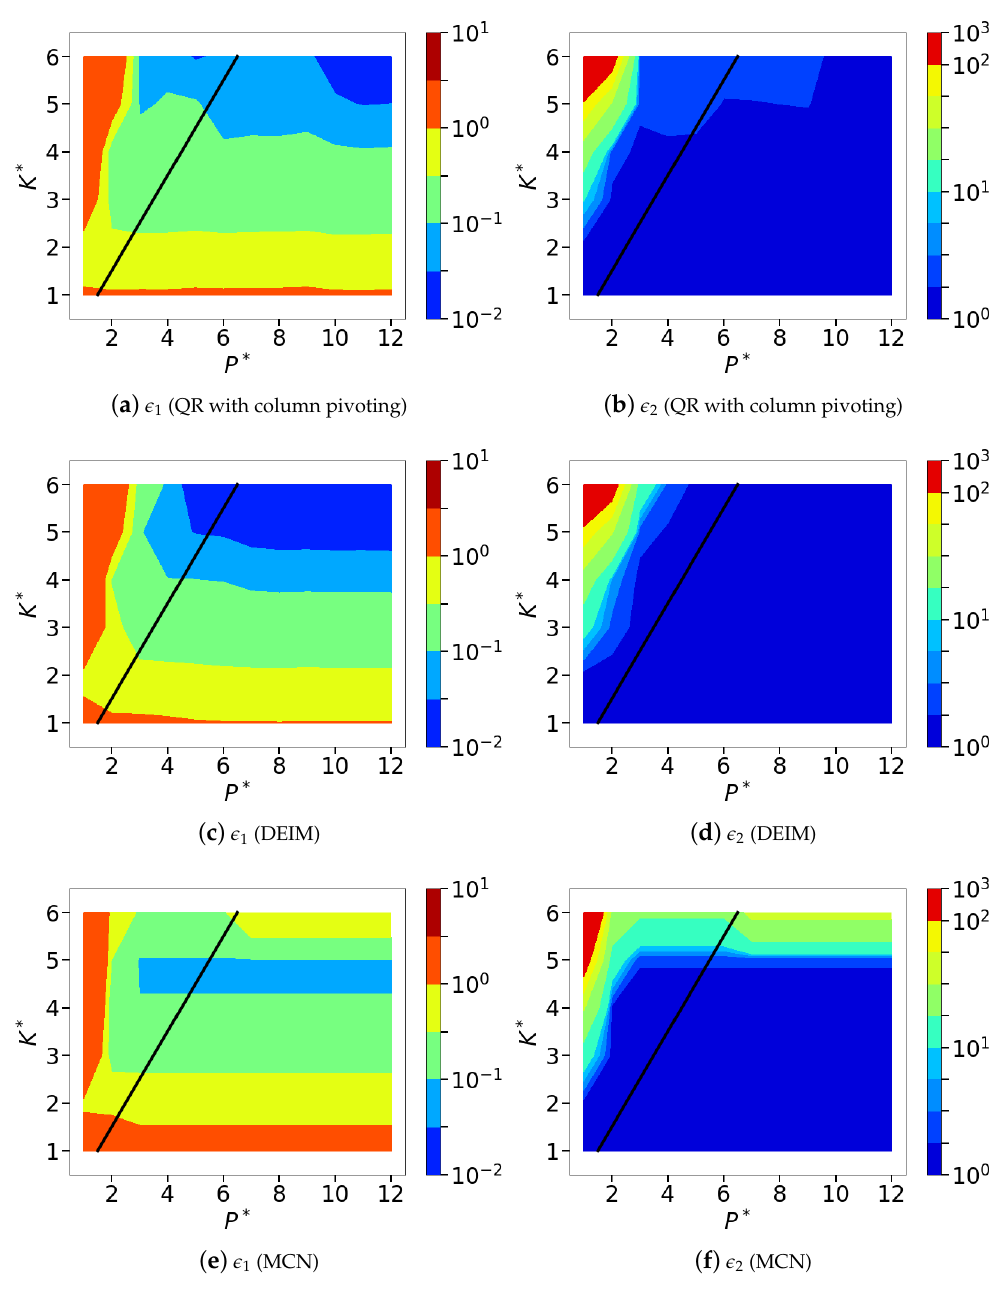
Figure 13. Isocontours of the normalized mean squared POD-based sparse reconstruction errors ( l 2 norm) corresponding to the different greedy sensor placement methods, namely, QR with column pivoting ( a , b ), DEIM ( c , d ) and minimum condition number ( e , f ). Subfigures ( a , c , e ), show the normalized absolute error metric, (cid:101) 1 and subfigures ( b , d , f ) show the normalized relative error metric, (cid:101) 2